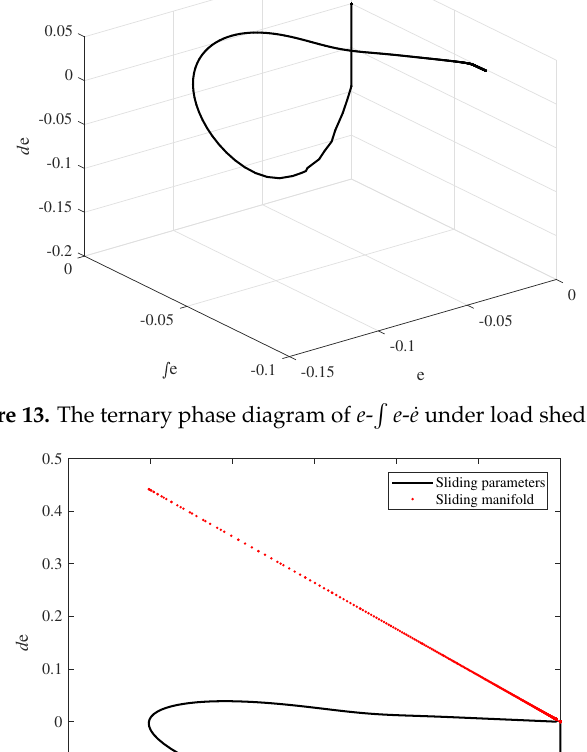
Figure 14. The plane phase diagram of e -˙ e under load